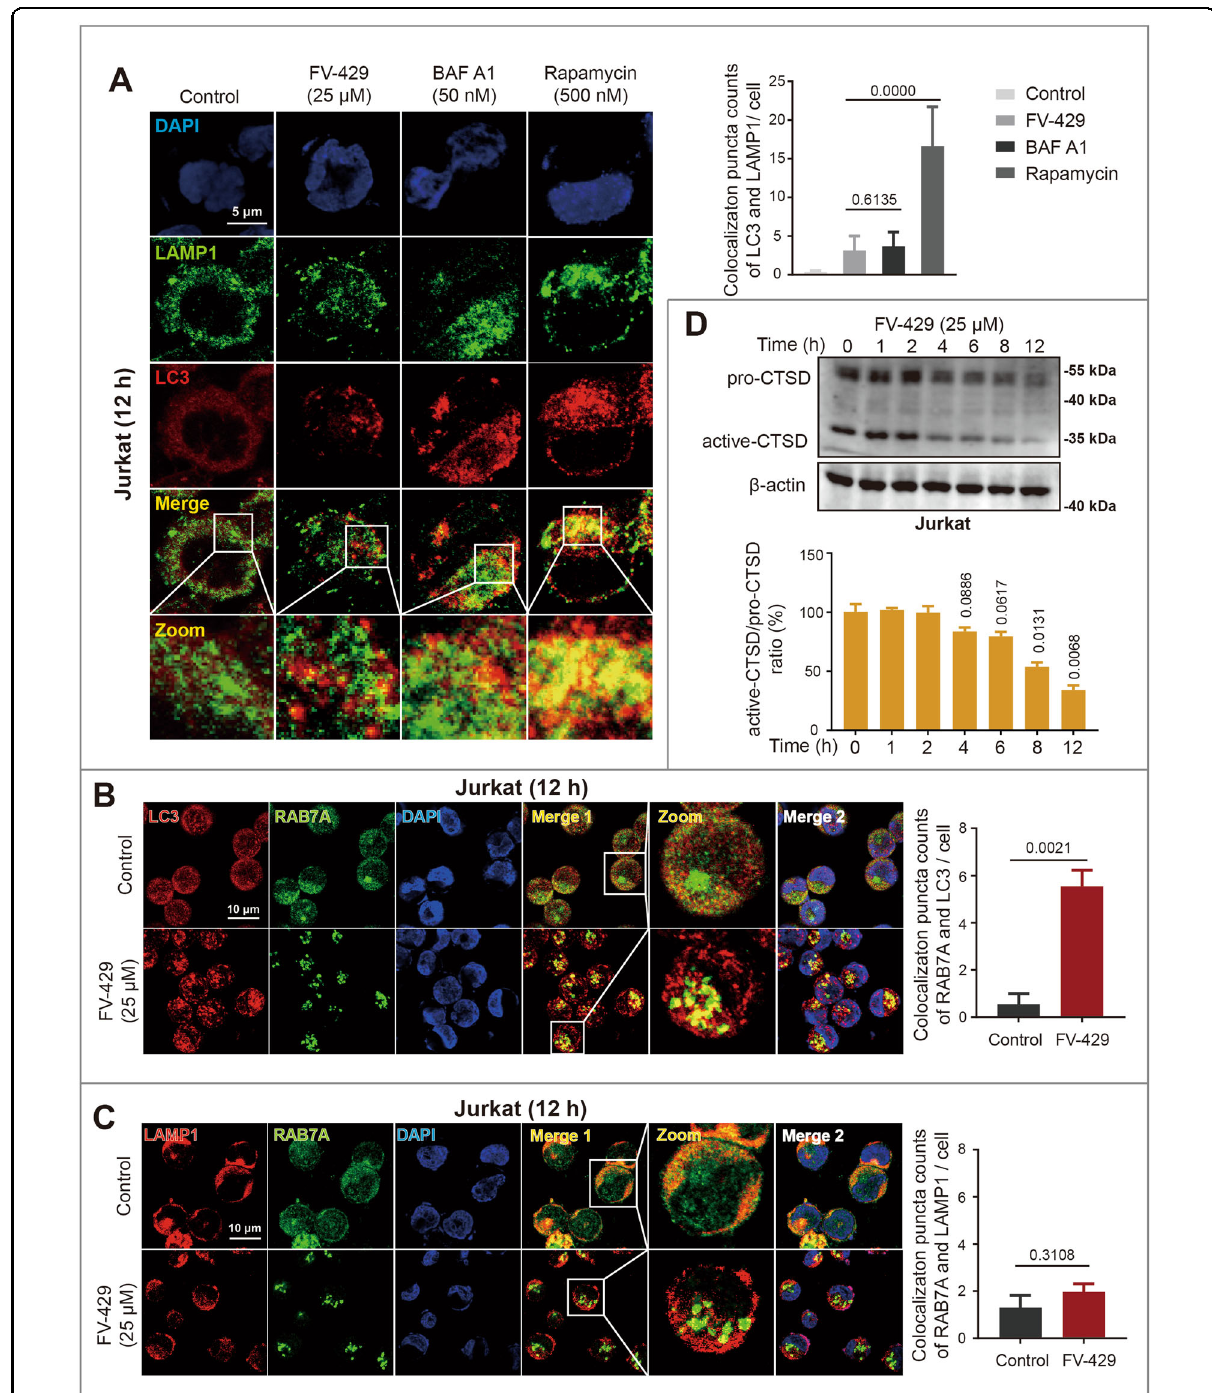
Fig. 3 FV-429 blocks lysosome-associated membrane fusion. A The Jurkat cells were treated with FV-429, BAF A1, and rapamycin for 12 h. The immuno fl uorescence analysis was performed with anti-LAMP1 antibody (green; lysosomes), anti-LC3 antibody (red; autophagosomes), and DAPI (blue; nuclei). The overlay levels were analyzed (scale bar: 5 μ m, the cells calculated in each group >100). B , C The Jurkat cells were treated with 25 μ M FV-429 for 12 h. The immuno fl uorescence analysis was performed with anti-LC3 antibody (red; autophagosomes), anti-RAB7A antibody (green), and DAPI (blue; nuclei) ( B ); or performed with anti-LAMP1 antibody (red; lysosomes), anti-RAB7A antibody (green), and DAPI (blue; nuclei) ( C ). The co- localization counts of RAB7A with LC3 or LAMP1 were calculated (scale bar: 10 μ m, the cells calculated in each group >100). D The Jurkat cells were treated with 25 μ M FV-429 for 0~12 h, and the expression of CTSD was determined by western blot. β -actin used as loading control (mean± s.e.m. for 3 independent experiments; p values are shown on the